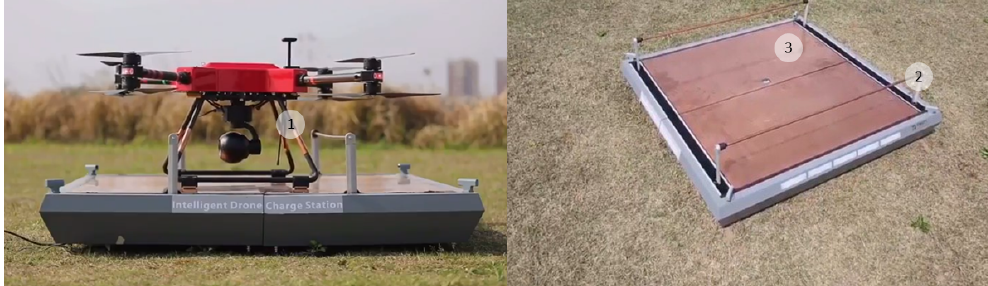
Figure 8. Ewatt Aerospace’s [46] Smart Charging UAV Platform without enclosure walls. 1, UAV leg with electrodes; 2, landing site; 3, electrodes.